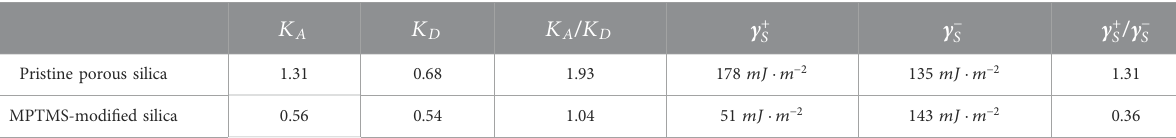
TABLE 2 Estimated acid – base parameters from the Gutmann and van Oss approachs at 120 ° C for porous silica before and after surface modi fi cation with MPTMS.